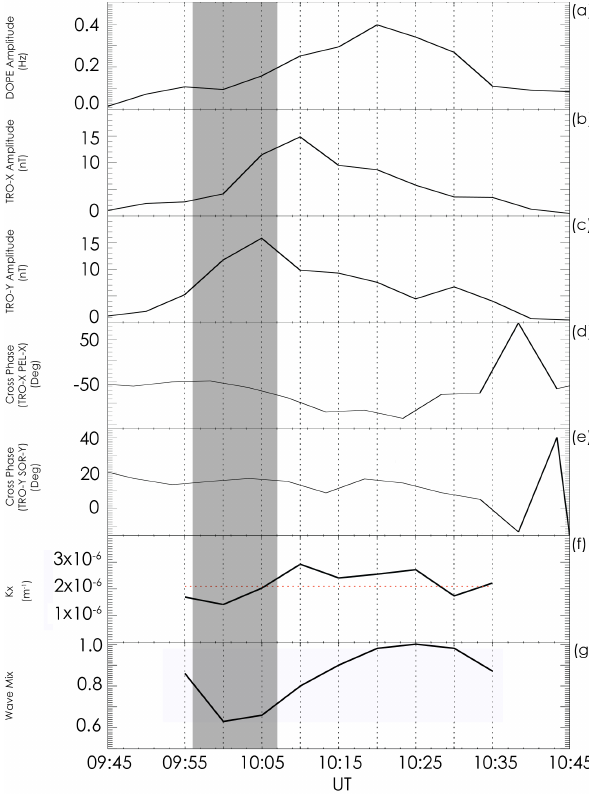
Fig. 5. Panel (a) presents the HF Doppler amplitude variation cal- culated from an integrated Fourier amplitude over a frequency range of between 1.7mHz–5.1mHz using a slip of 5min. Panels (b) and (c) show the TRO-X and TRO-Y amplitudes found using the same technique as for panel (a). Panel (d) shows the X component cross phase between IMAGE stations TRO and PEL. Panel (e) shows the Y component cross phase between the azimuthally separated IM- AGE stations TRO and SOR. Panel (f) shows the k x time evolution determined from the ratio of the amplitudes of TRO-X and TRO-Y. The overplotted horizontal red dotted line shows the constant value of k x assumed during the study. Panel (g) shows the implied ULF wave mix evolution. The overplotted dot-dash lines show the 5min intervals when the wave mix is calculated. The grey shaded region shows the possible range of arrival times of the effects of the solar wind dynamic pressure increase as measured by the ACE space-